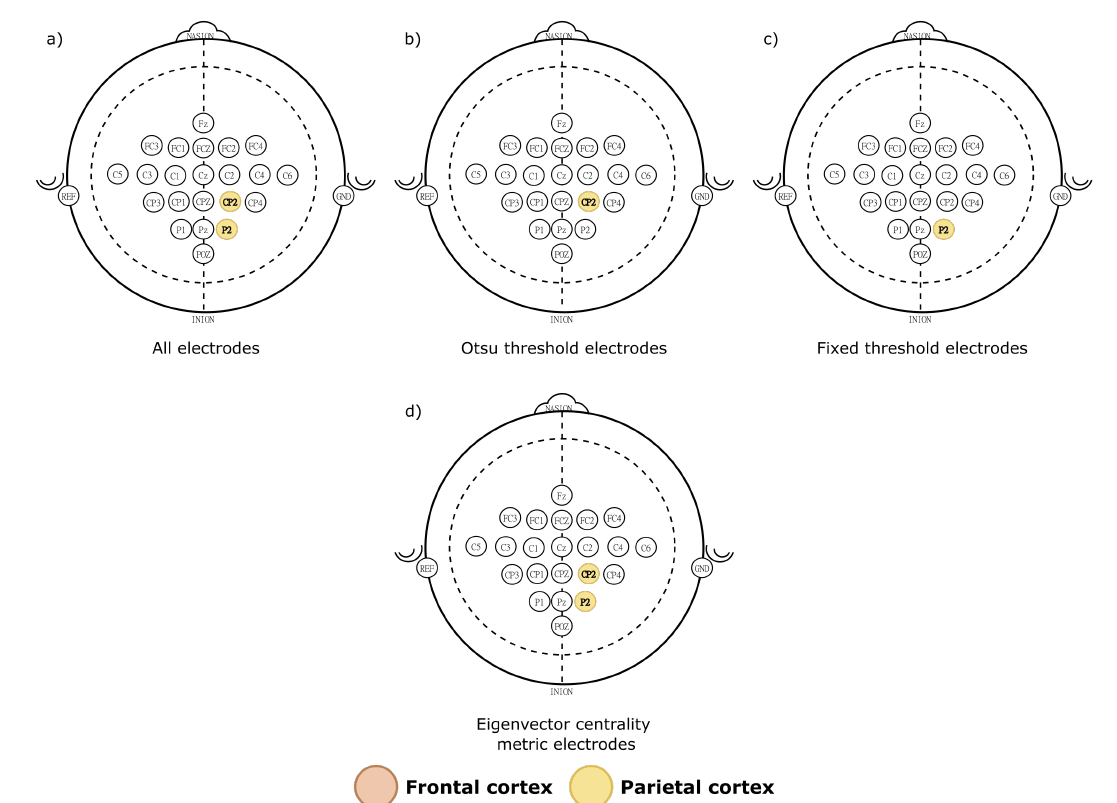
Figure 11. The electrodes with significative differences according to the post hoc MANOVA. In ( a ) all electrodes obtained with the post hoc analysis; ( b , c ) display the significative electrodes for the multilayer metrics with significative differences, while ( d ) identify the electrodes that were significatives for both thresholds.